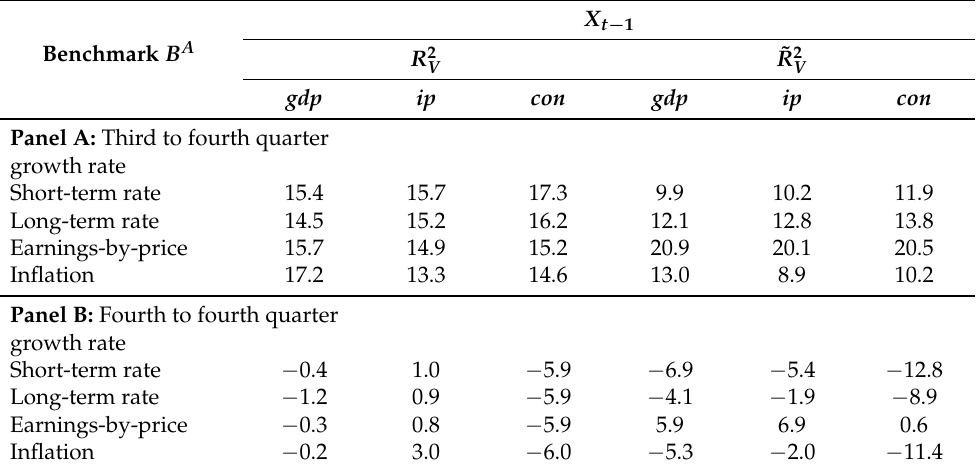
( A ) . The prediction problem t